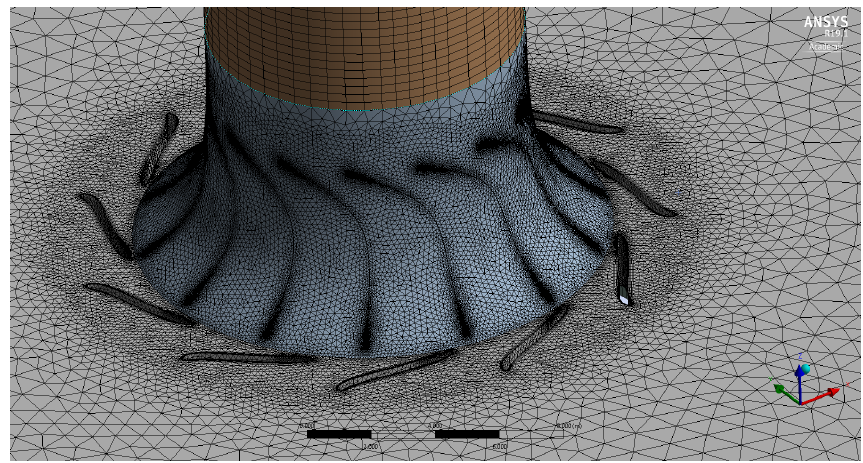
Figure 8. Grid completed in ANSYS Meshing using the 3D turbine model.